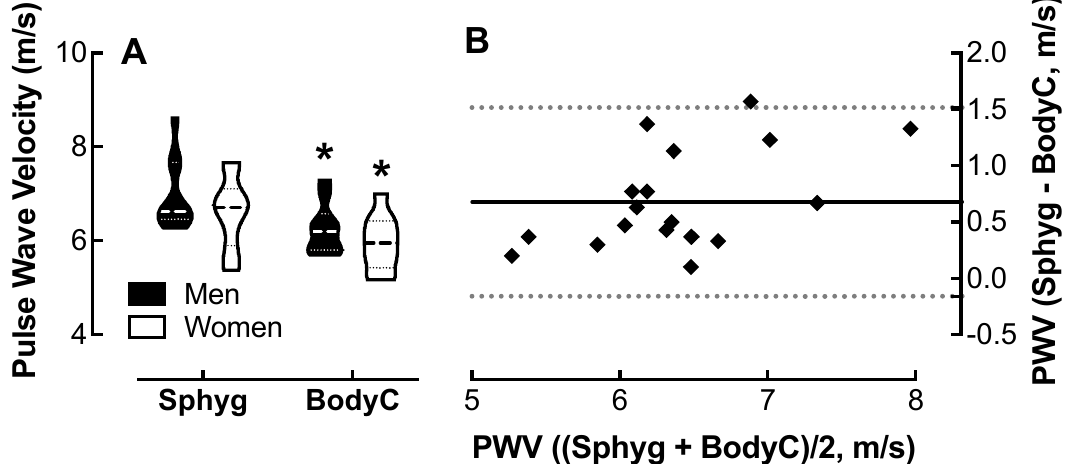
Figure 1. Comparison of pulse-wave velocity (PWV) measured by the Body Cardio compared with SphygmoCor determinations. ( A ) Violin plot of PWV measured by the SphygmoCor (Sphyg) and Body Cardio (BodyC) in men and women; p < 0.01, Sphyg vs. BodyC by two-way ANOVA; n = 10 / group. ( B ) Q-Q plot of PWV determined by the Sphyg and BodyC. Each data point represents duplicate or triplicate measures in one study participant. PWV, pulse-wave velocity.